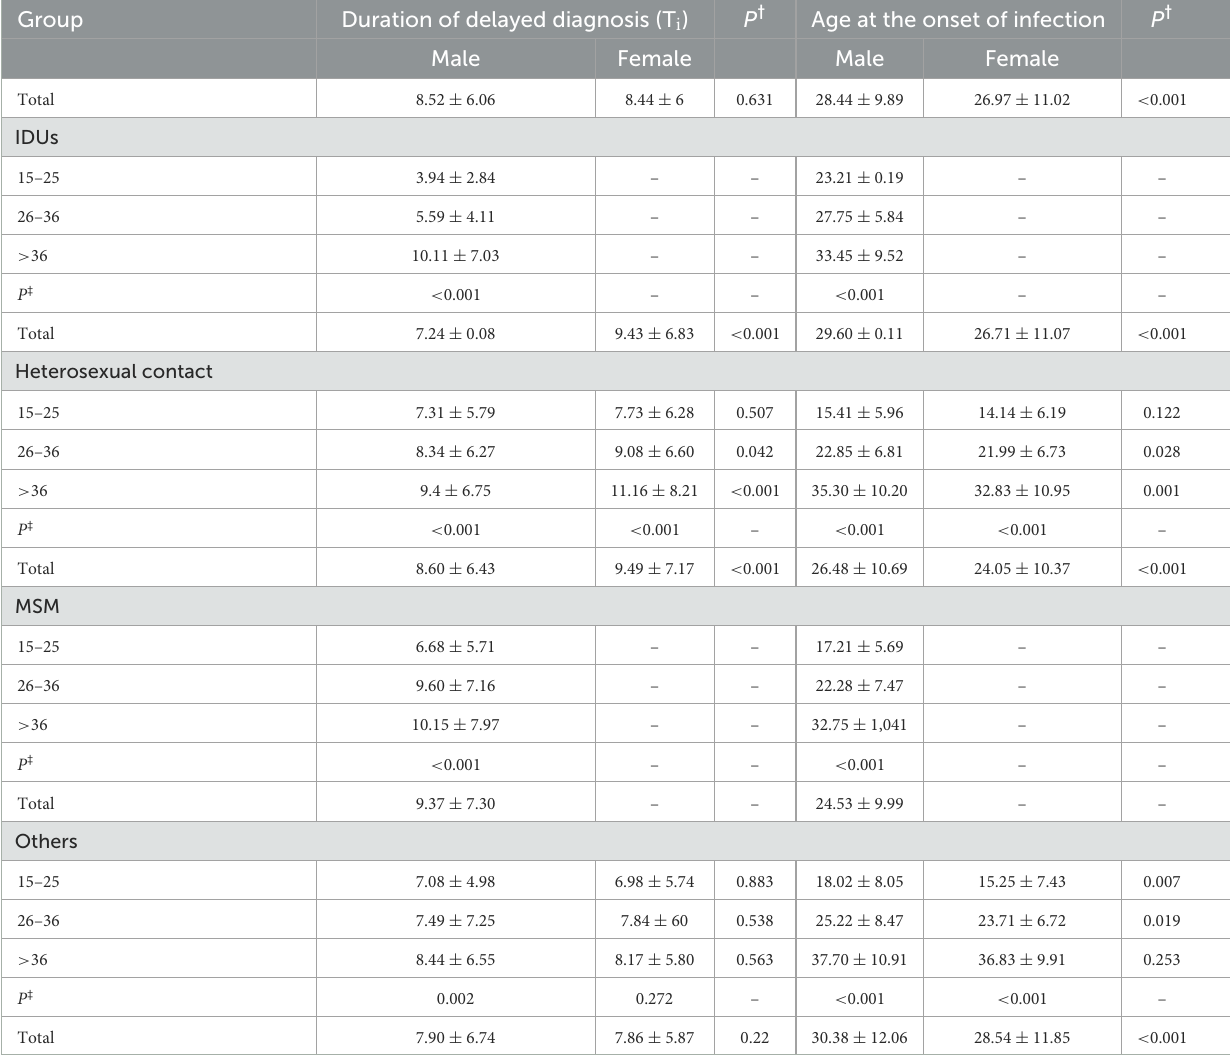
TABLE 3 Duration of delayed diagnosis and age at the onset of infection in HIV patients using CD4 depletion model on the national HIV/AIDS surveillance system database (HASS).